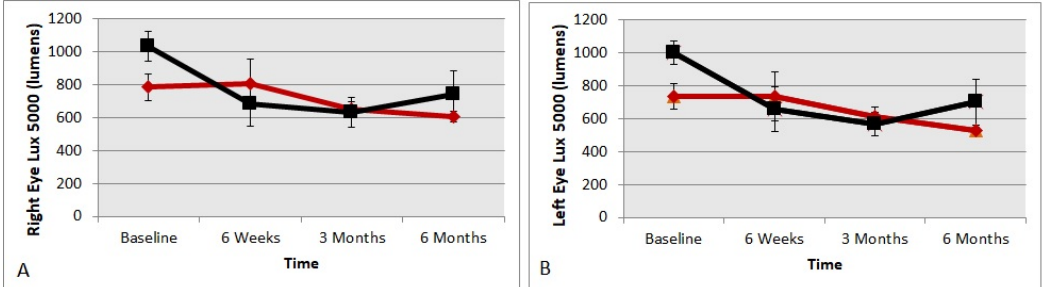
Figure 3. Preferred luminance in lumens chosen or ideal subjective luminance for right eyes and left eyes, over time, viewing a highly stressed 6500° blue Kelvin color temperature light source, simulating bright daylight driving conditions. A = right eye; B = left eye. The red diamond symbols represent the treatment group and black square symbols represent the placebo group.